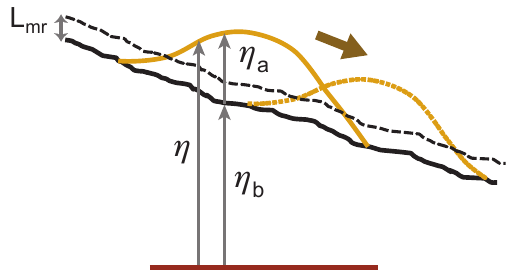
Figure 3. Schematic diagram illustrating the propagation of a wave of sediment over bedrock (orange line shifting to dashed orange line over time). Here η b denotes the elevation of the bottom of the bedrock relief (black line), L mr denotes the bedrock macro- roughness thickness (dashed black line), η a denotes the thickness of the alluvial cover (which may be less than or greater than L mr ) and η = η b + η a denotes the elevation of the top of the